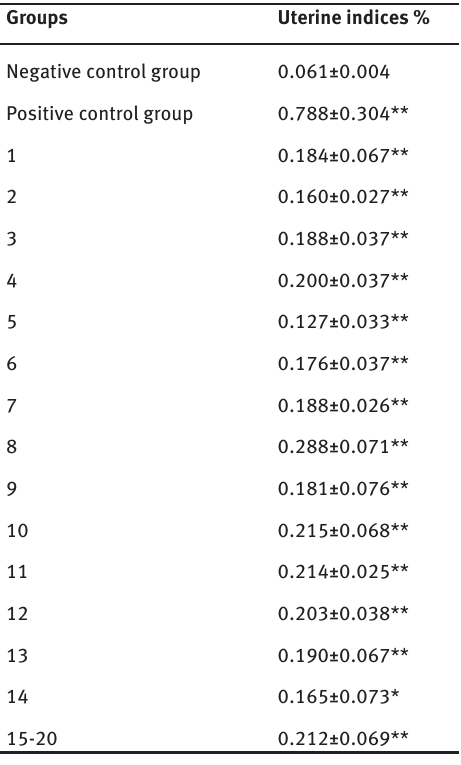
Table 3: Effects of total glycosides of Cistanche deserticola from different purification technologies on the uterine indices of immature